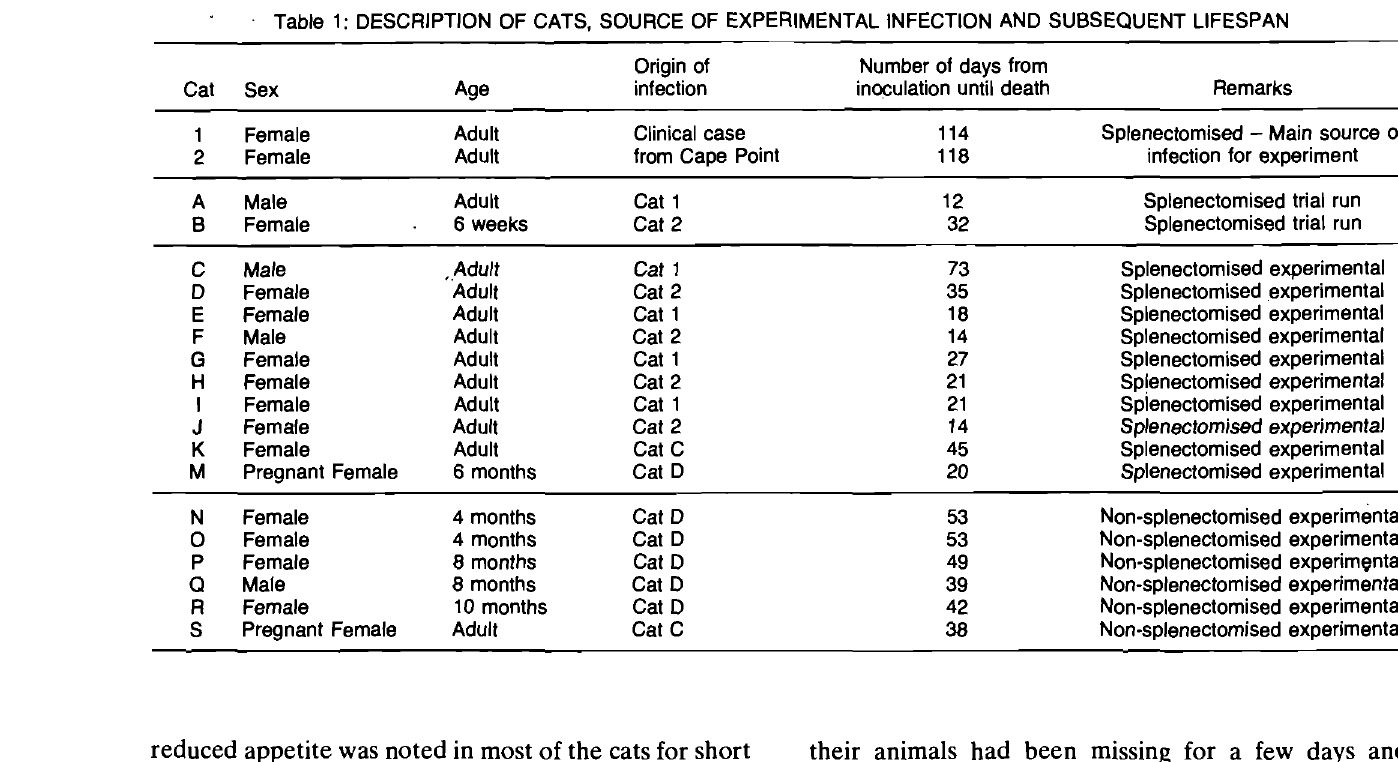
Table 1: DESCRIPTION OF CATS, SOURCE OF EXPERIMENTAL INFECTION AND SUBSEQUENT LIFESPAN